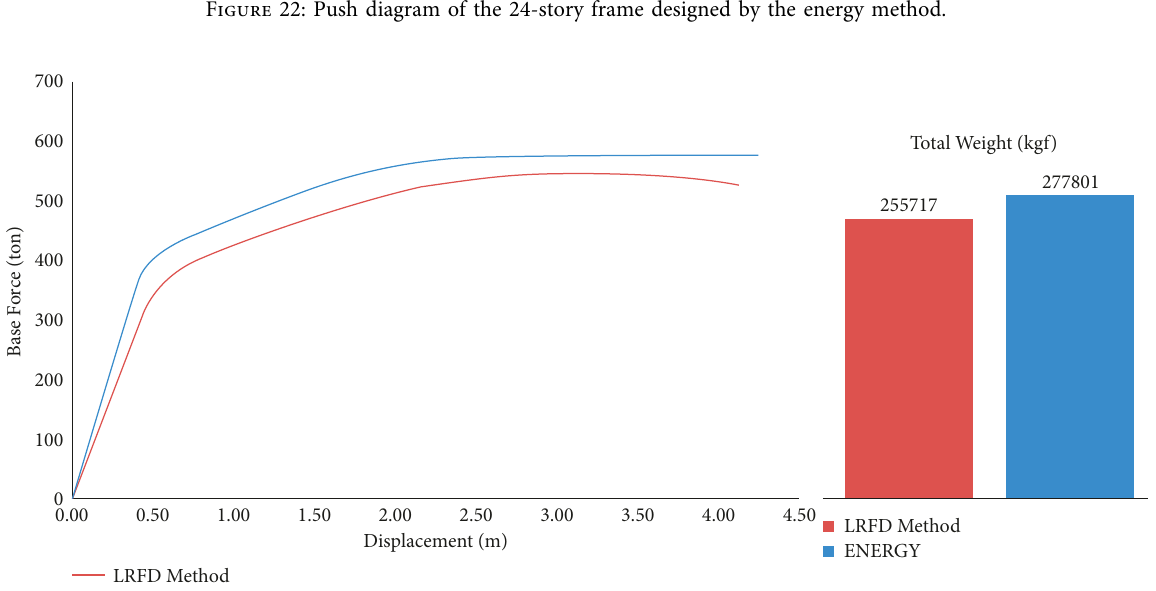
Figure 23: Comparing the push diagram and weight of the 24-story steel frames designed by the energy and LRFD